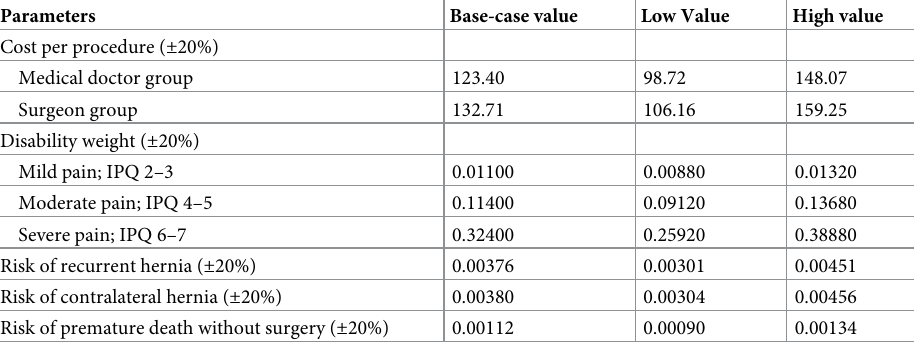
Table 4. Values used in one-way deterministic sensitivity